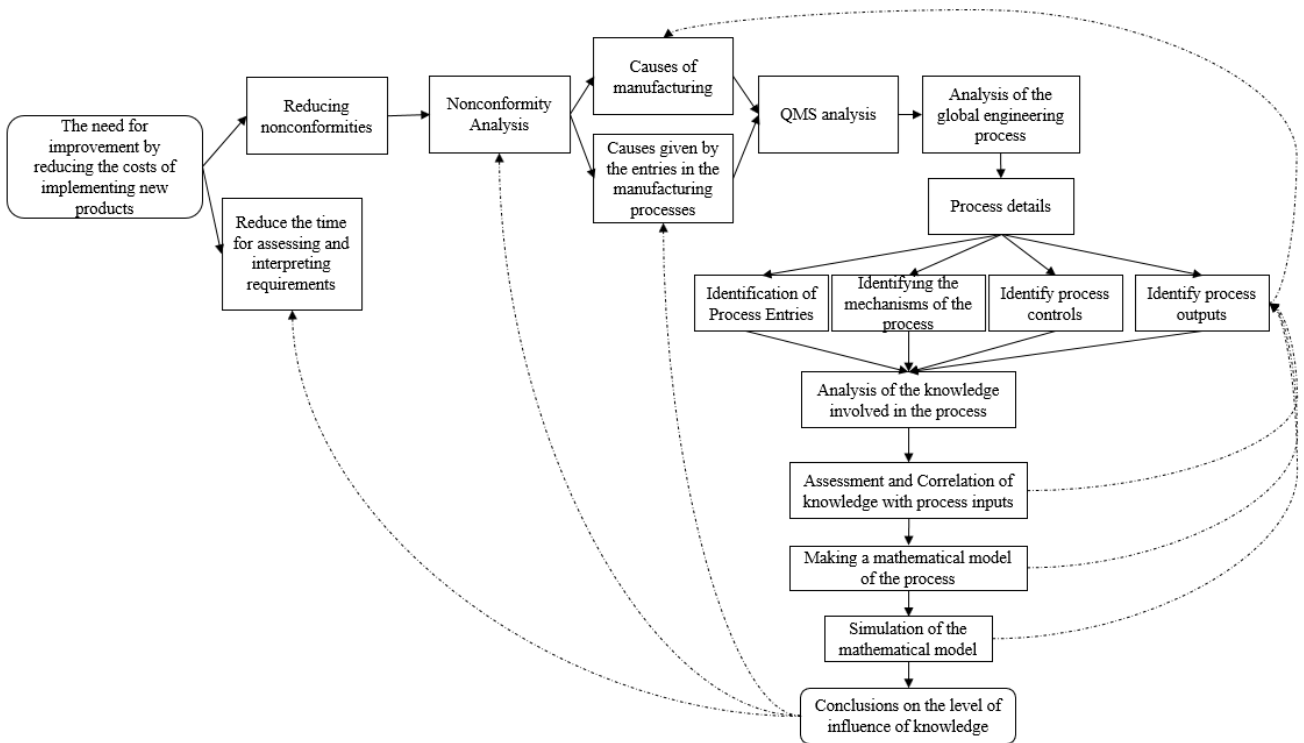
Figure 1. Plan to address the relationship between product requirements in the engineering process within an aerospace industry organization.